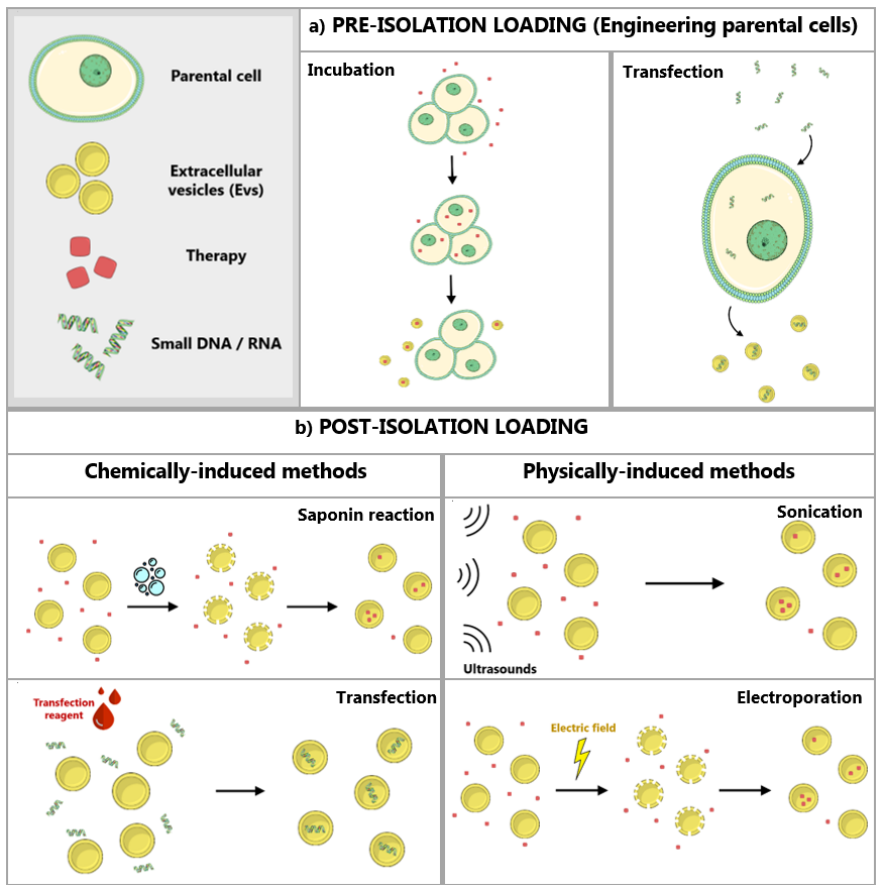
Figure 3. Extracellular vesicles ( EVs ) loading methods. ( a ) EVs can be loaded before isolation by engineering their parental cells. This procedure can be achieved by incubation of the parental cells with the desired cargo or by transfection of the cells. EVs secreted by those cells will already contain the cargo. ( b ) EVs can be loaded with a desired cargo after being isolated from the sample. This procedure can be chemically induced (through transfection or saponin reaction) or physically induced (through sonication or electroporation).